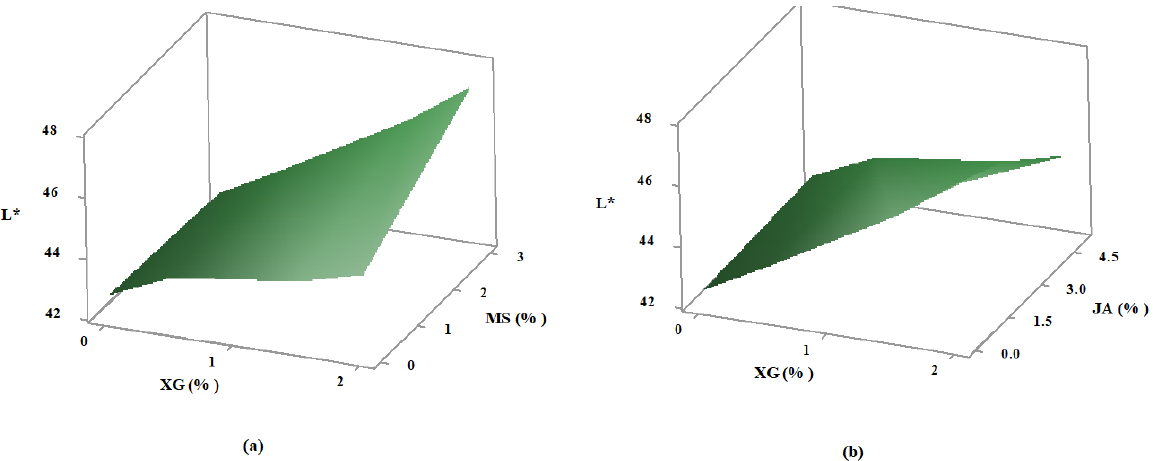
Figure 6. Response surface plot of the correlative effects of ( a ) maple syrup (MS) and xanthan gum (XG); ( b ) Jerusalem artichoke (JA) and XG on the color parameter L* of walnuts butter.